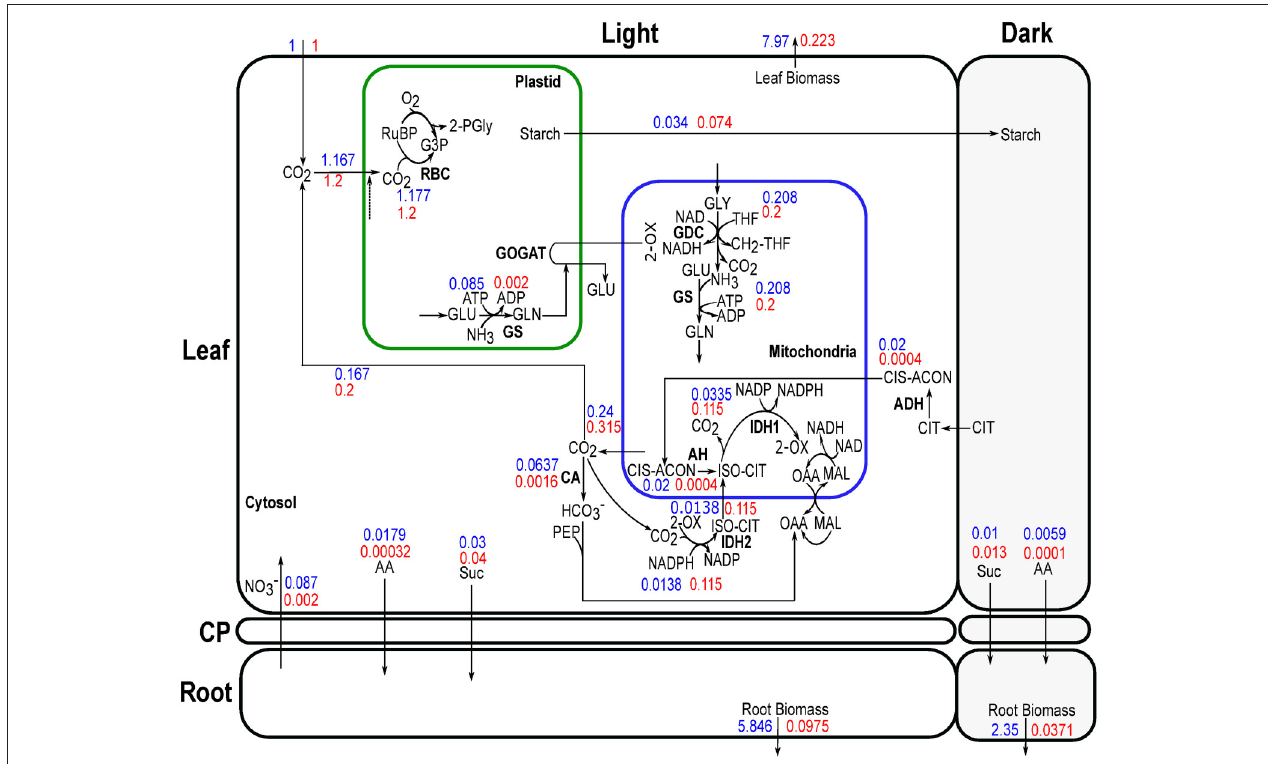
FIGURE 7 | Simulated flux distribution in a day under growing and mature stages of Arabidopsis leaf and root in N low . The days correspond to lowest QD (15.84) during the rosette development (day 27) and highest QD (16.177) during maturation (day 36) in Figure 3B are shown with blue and red font, respectively. Flux values were normalized to per net CO2 fixed. Flux values for AA represent the normalized sum of all amino acids. Note that the thickness of the arrows is not scaled to relative flux magnitudes. CIS-ACON, cis-aconitate; PEP, phosphoenolpyruvate; HCO − 3 , hydrogen